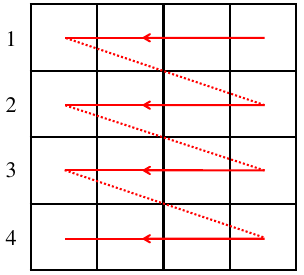
FIG. 23. Ordering of the 1d Jordan-Wigner transformation on the square